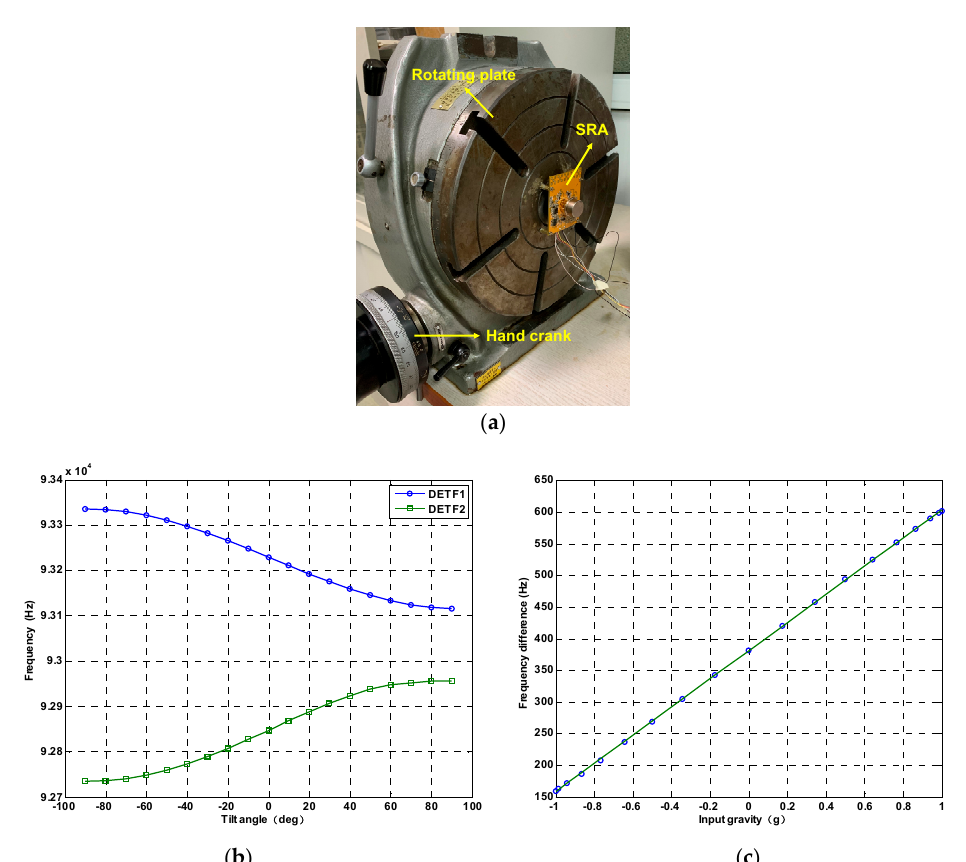
Figure 11. The scale factor testing. ( a ) The SRA is fixed on the indexing plate to test the scale factor; ( b ) The frequency output of two DETFs; ( c ) Frequency difference vs. input gravity.